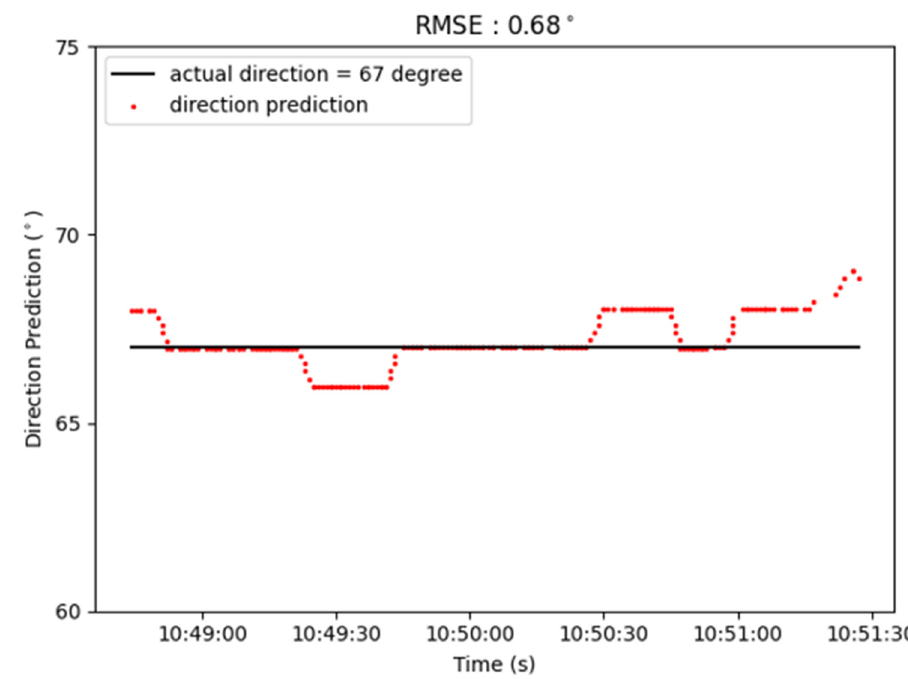
Figure 13. Single station measurement result.